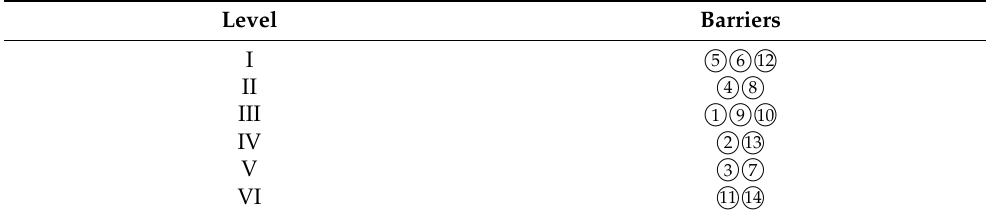
Table 7. The partition result of